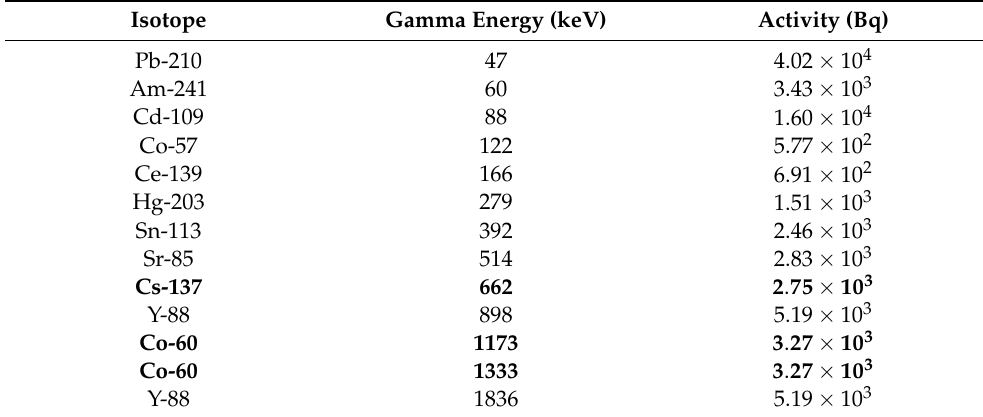
Table 1. Radioactive emitters and activities (at the materials time of production in 2016) contained within the Eckert and Ziegler™ multi-radionuclide calibration source. The isotopes successfully identified by the peak identification program during testing (detailed in Section 3) are in